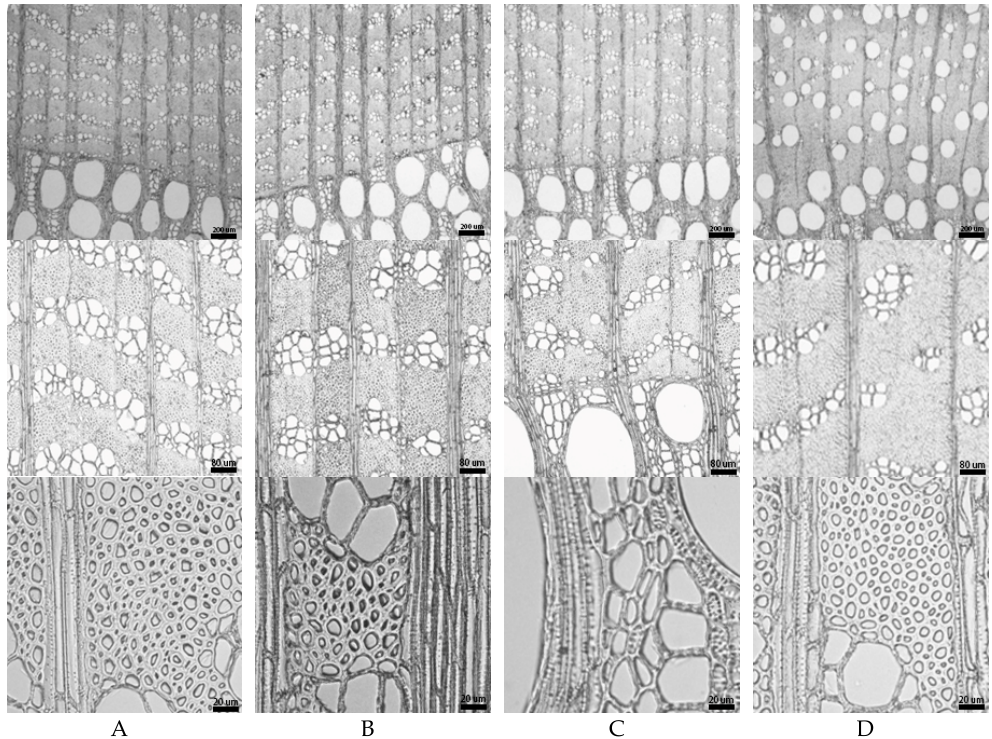
Figure 5. Distinct growth ring boundaries in the transverse section of elm wood. Pictures in column ( A ) #2, ( B ) #3, ( C ) #10, and ( D ) #21 were photographed from the 2nd, the 3rd, the 10th, and the 21st sample splints, respectively.